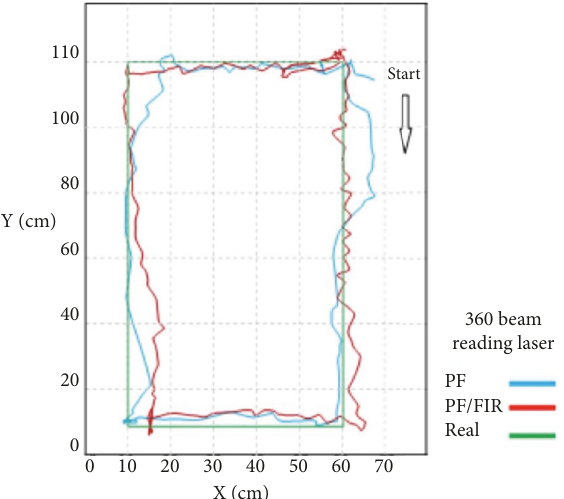
Figure8:TheestimatedpathinParticleFilteronlyversusthehybrid (PF/FIR) with 360 laser reading points.